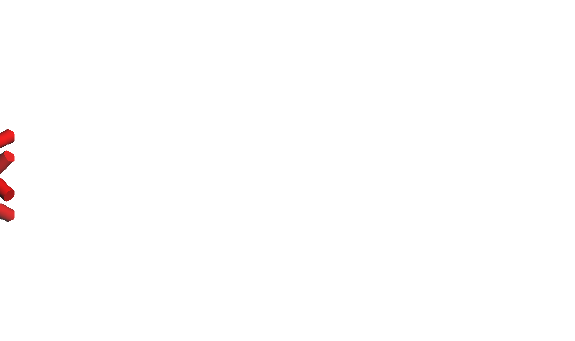
Figure 12. Schematic representation of a CuO unit cell. The salmon pink spheres denote Cu atoms, and the red spheres denote O atoms, respectively.